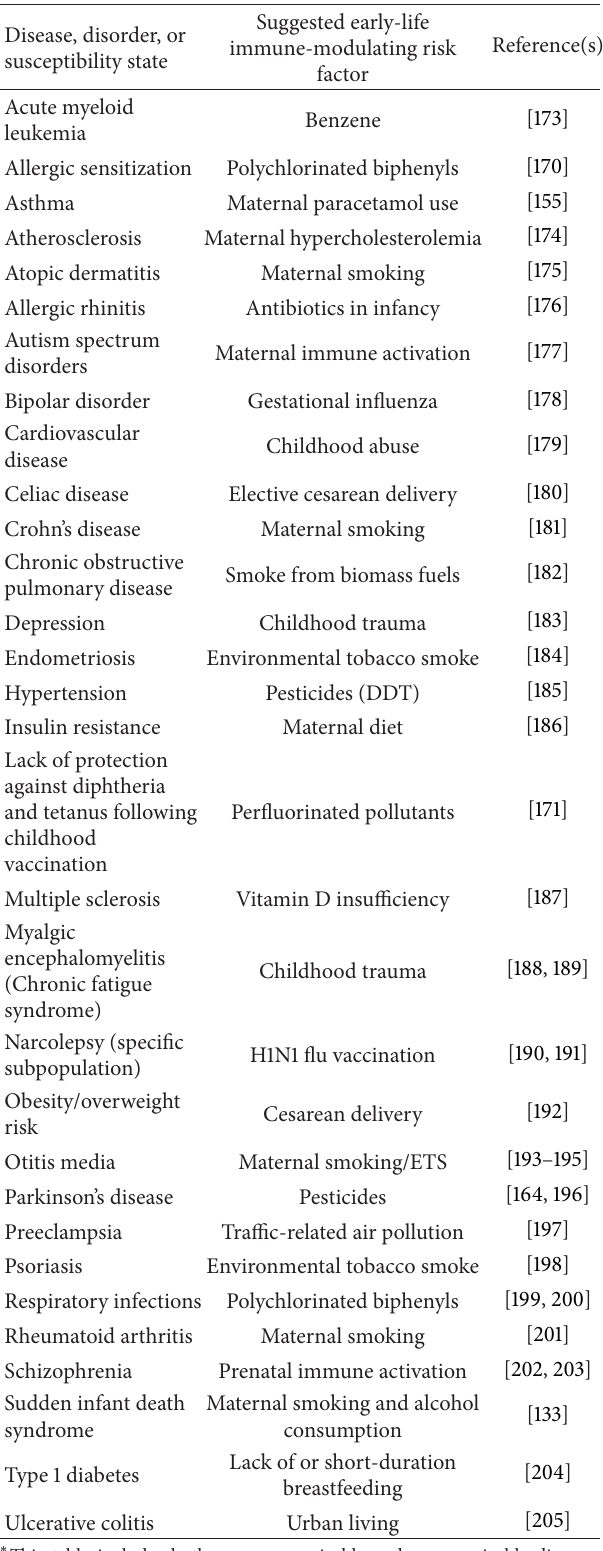
Table 1: DIT and increased risk of human disease ∗ . Disease, disorder,